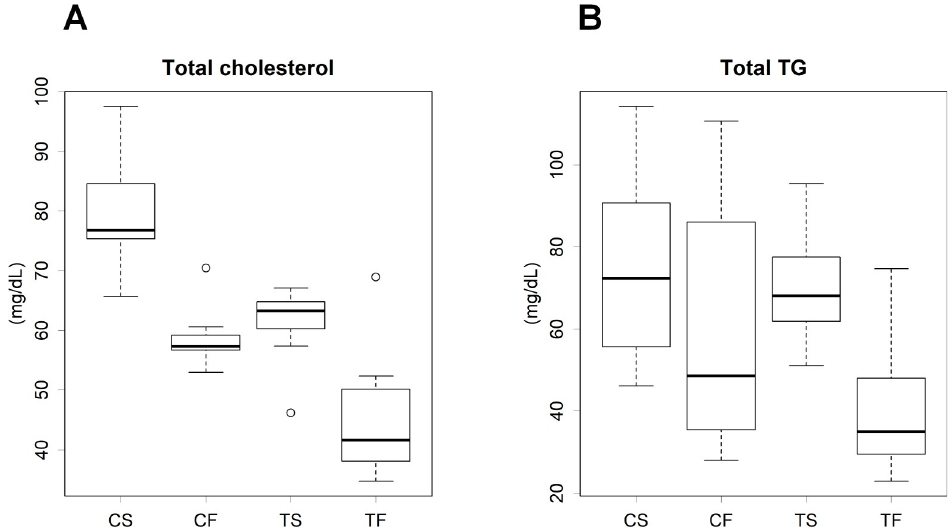
Fig 3. Serum lipid levels in rats. ( A ) Cholesterol. ( B ) TG. C, Casein; T, tofu; S, soy oil; F, fish oil. Values are means ± SD, n = 7–8. Results of statistical analyses are presented in S1 Appendix. Results of the post hoc analysis and 95% family-wise confidence levels are also shown. Results of statistical analyses are presented in S1 Appendix.